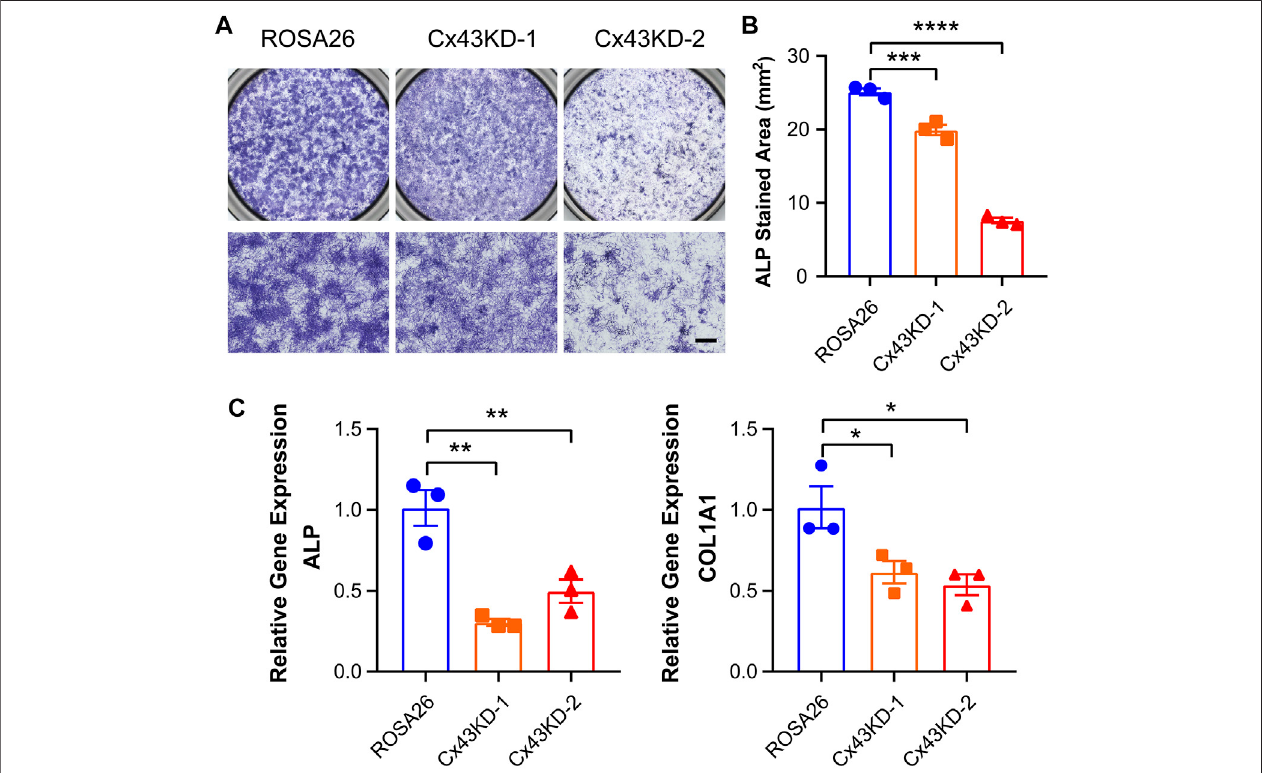
FIGURE 4 | Cx43 knockdown decreased alkaline phosphatase and type I collagen expression in IDG-SW3 cells. (A) Representative images of ALP staining in ROSA26 or Cx43 KD IDG-SW3 cells at day 9 of the induction of differentiation. Lower panels show an enlarged view of the center regions of upper panels. Scale bar, 500 μ m. (B) Quanti fi cationofALP-stainedareabyNIHImageJsoftware. (C) TotalRNAwaspreparedfromROSA26orCx43KDIDG-SW3cells.ThemRNAlevelsofALP and COL1A1 were determined by real-time PCR normalized to GAPDH. Data shown are mean ± SEM. *, p < 0.05, **, p < 0.01, ***, p < 0.001, ****, p <